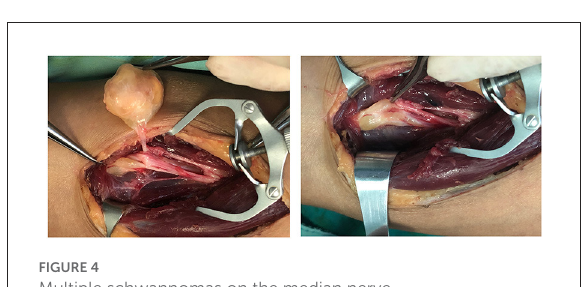
FIGURE4 Multiple schwannomas on the median